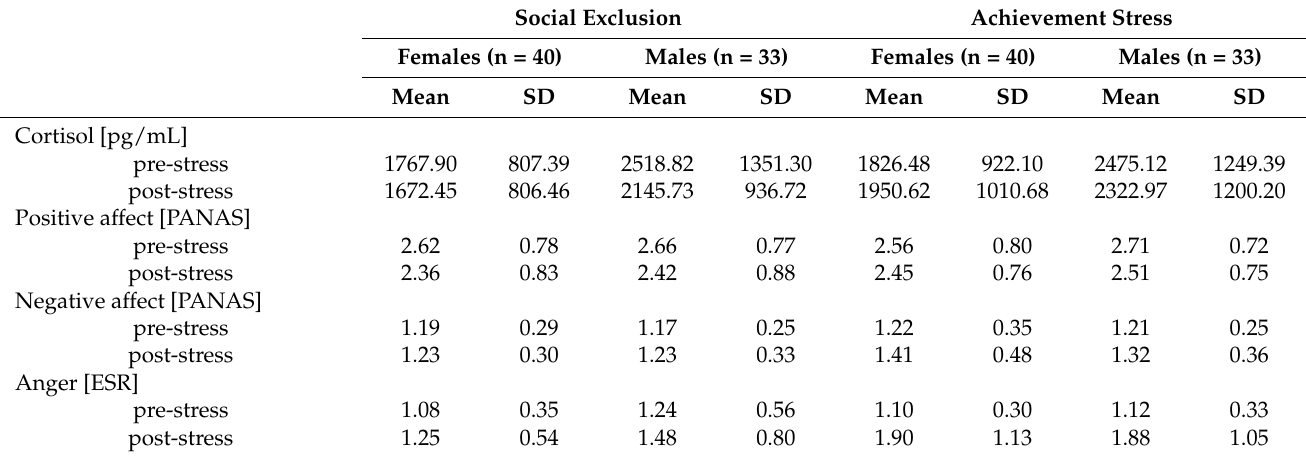
Table A1. Hormonal levels and subjective ratings pre- and